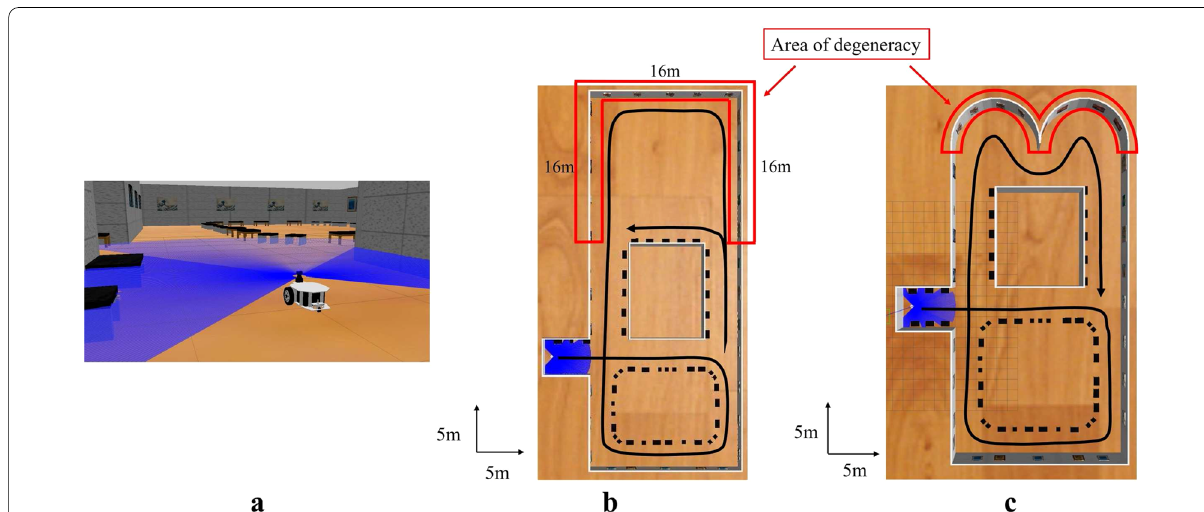
Fig. 6 Simulation environment. a Robot view, b A top view of the environment for dealing with degeneracy in the direction of translation, c A top view of the environment for dealing with degeneracy in the direction of